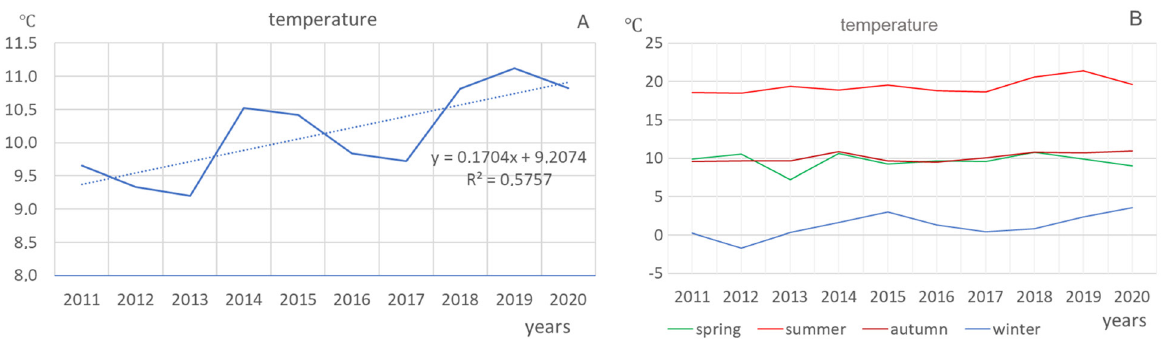
Fig. 1. The course of the average annual – (A) and seasonal – (B) values of air temperature in Poznań in years 2011–2020 with the annual trend